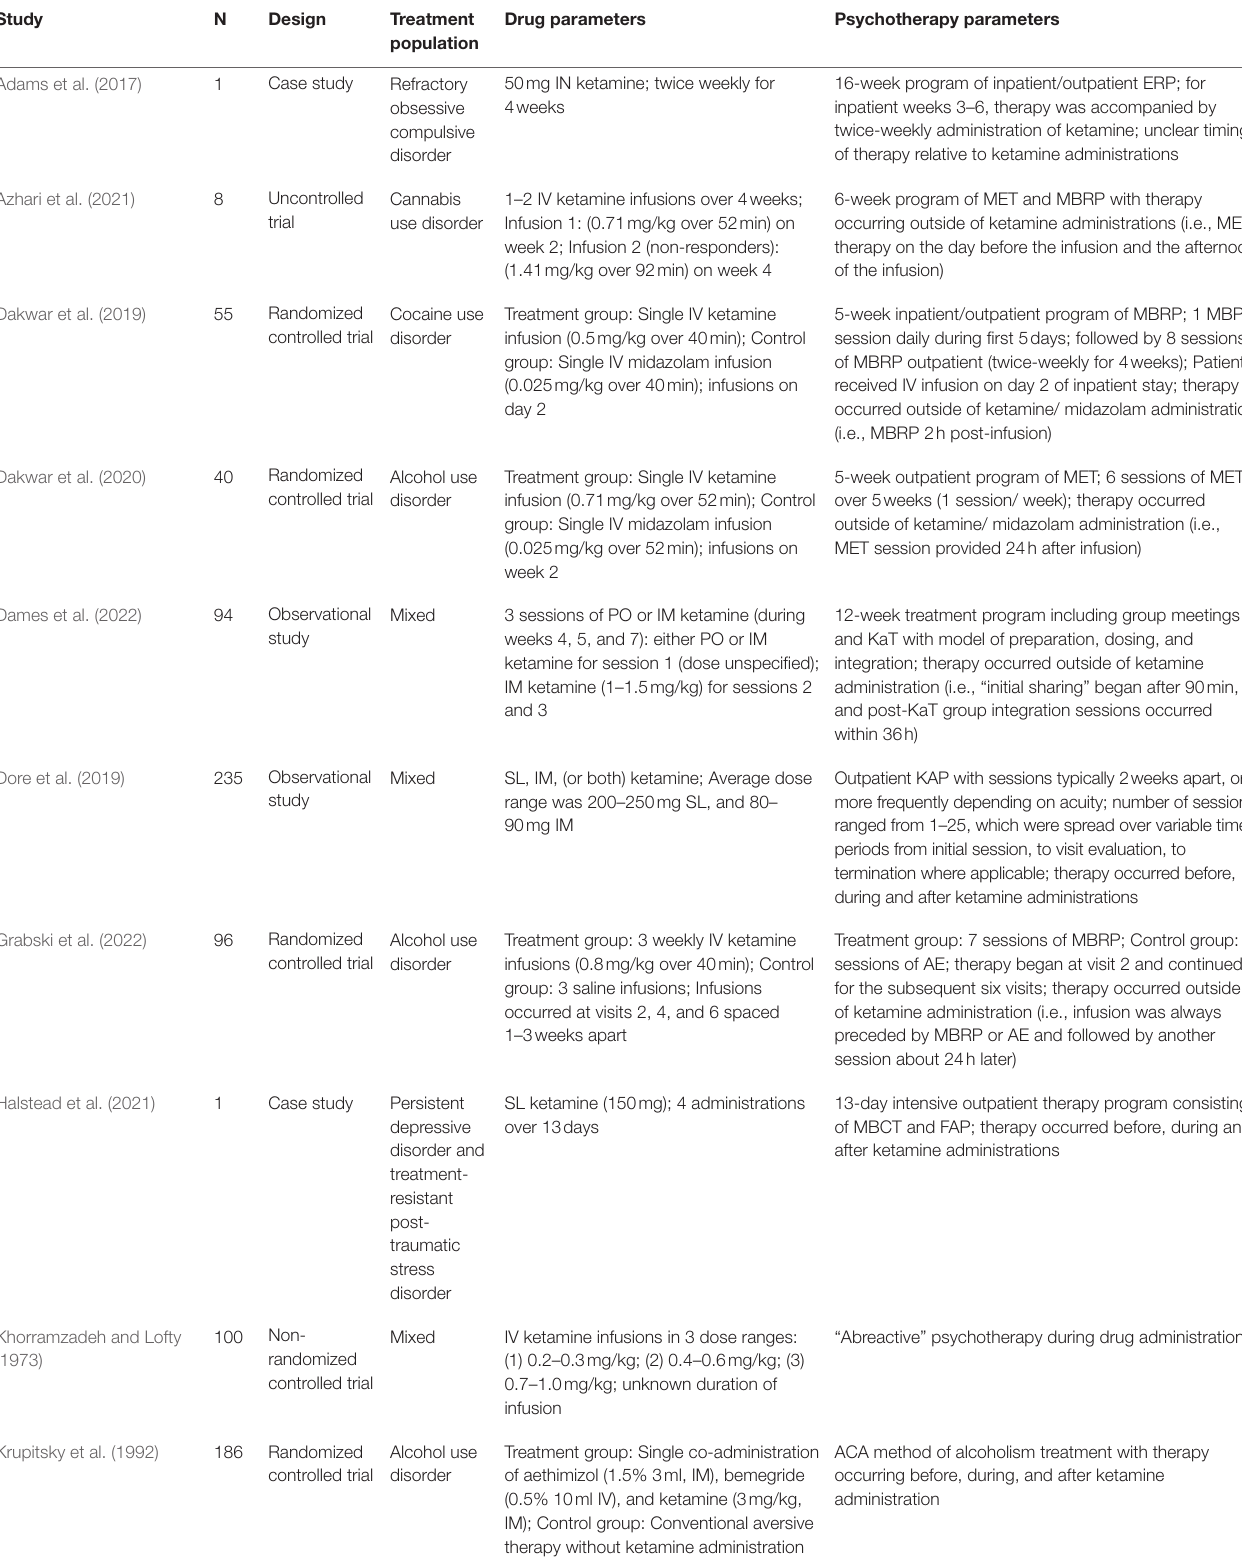
TABLE 1 | Characteristics of studies reviewed using ketamine and psychotherapy. Study Psychotherapy